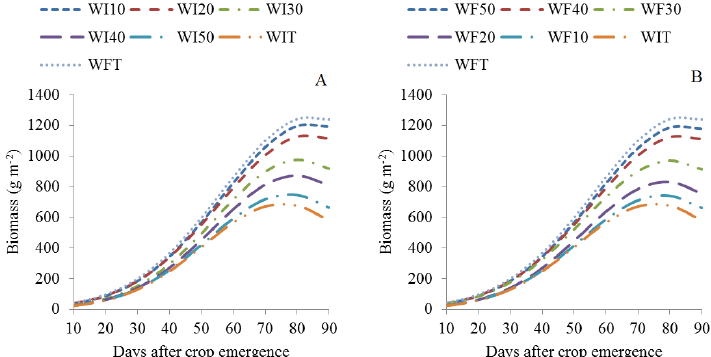
Fig. 3. Dry bean biomass trend over time at different treatments of weed interference (A) and weed free (B) periods. WI10, WI20, WI30, WI40 and WI50: weed infested periods until 10, 20, 30, 40 and 50 days after crop emergence, respectively; WF10, WF20, WF30, WF40 and WF50: weed free periods until 10, 20, 30, 40 and 50 days after crop emergence, respectively; WIT and